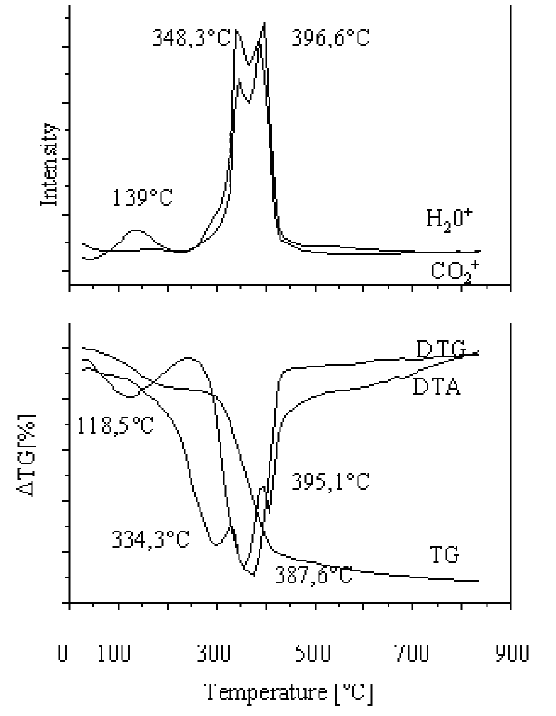
Fig. 1 DTA - TG of sample